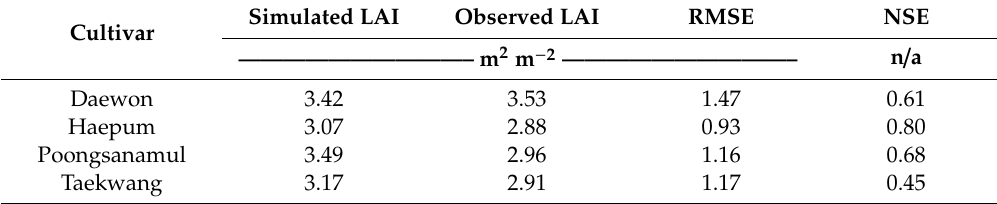
Table A4. Error statistics of root mean square (RMSE) and Nash–Sutcli ff e e ffi ciency (NSE) in comparison between simulated and observed values of leaf area index (LAI) for soybean cultivars, simulated with the vegetation index input option for the RSCM regime using the data obtained at Jeonnam Agricultural Research and Extension Services in Naju, Chonnam province, South Korea in